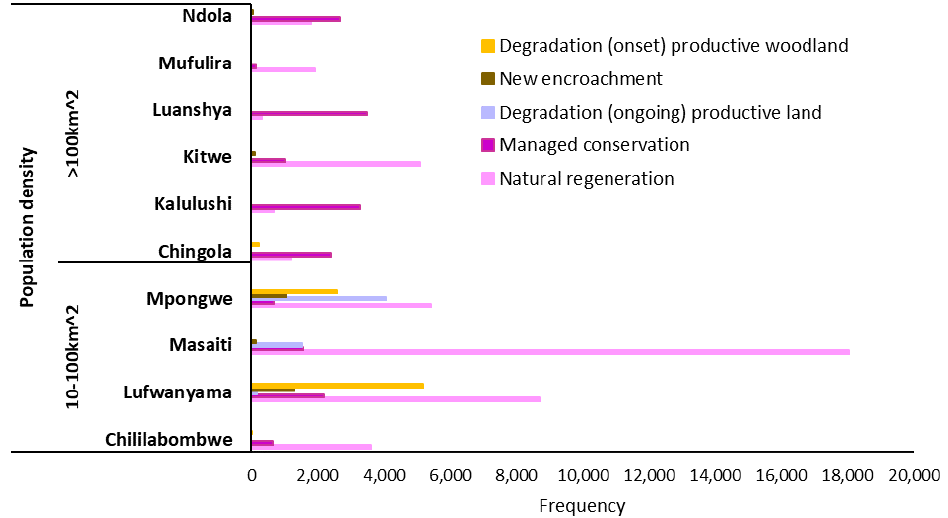
Figure 15. Land change dynamics represented according to districts of Copperbelt.